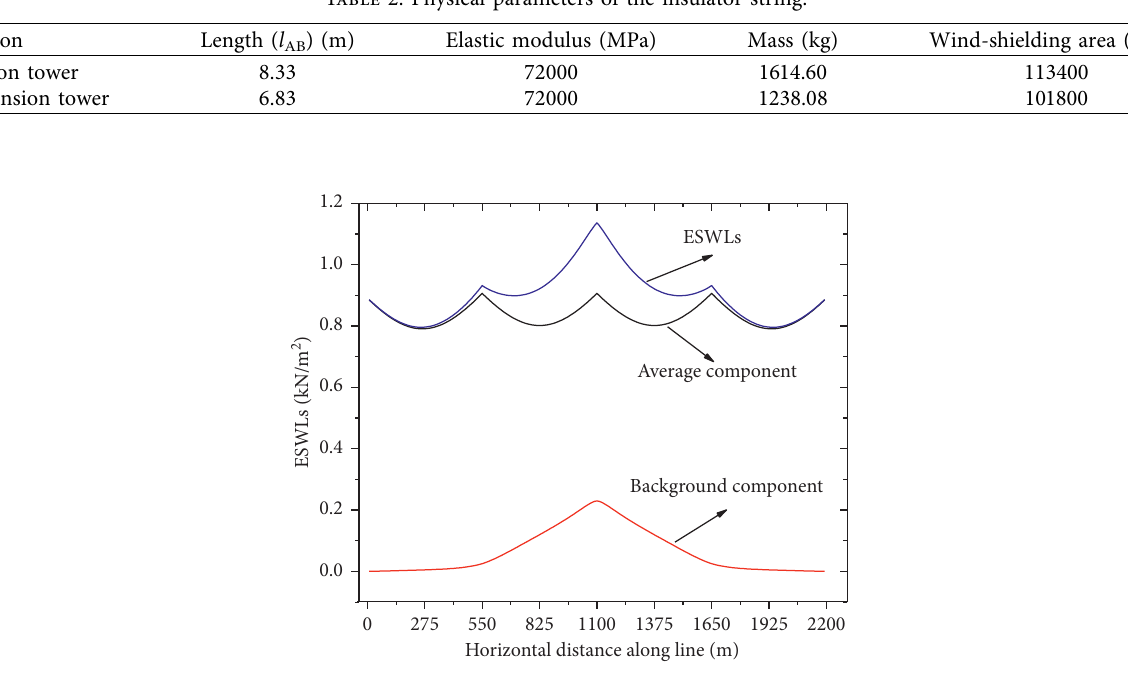
Figure 3: Equivalent static wind loads and the distributions of their components.